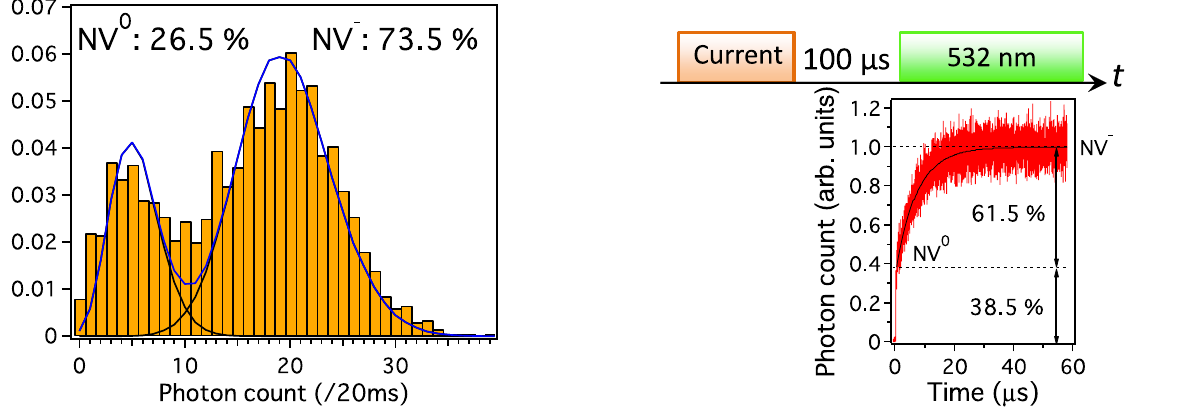
FIG. 5. Charge-state population of the undoped sample. FIG. 6. Laser-induced charge-state transition from NV 0 to NV −